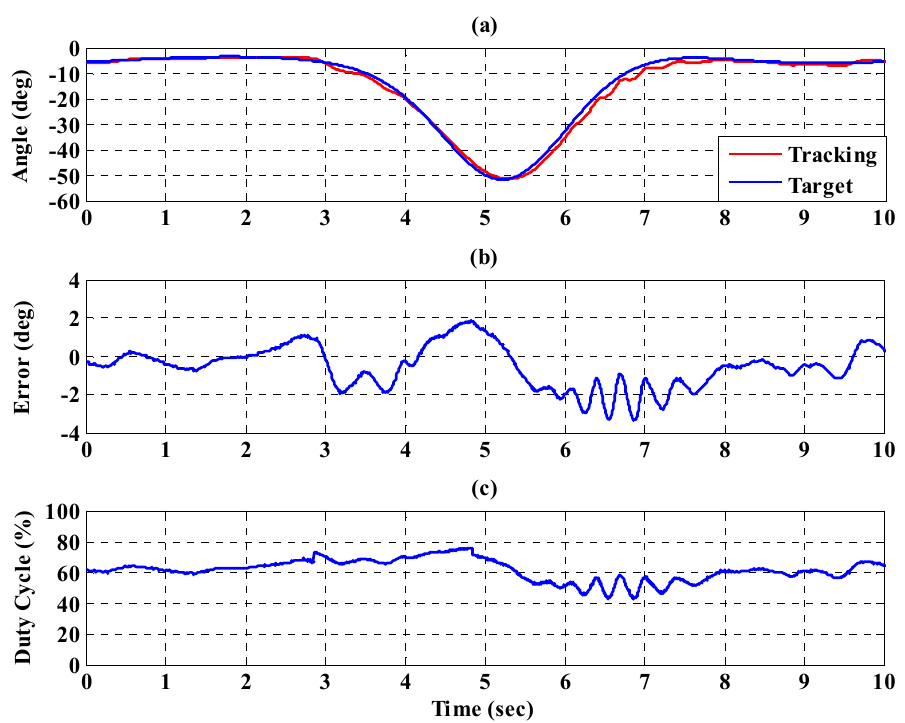
Figure 26. Tracking response of the interval type-2 fuzzy sliding pulse-width modulation controller on the right hip for the PGOS. ( a ) Output response; ( b ) tracking error; ( c ) pulse-width modulation control signal.